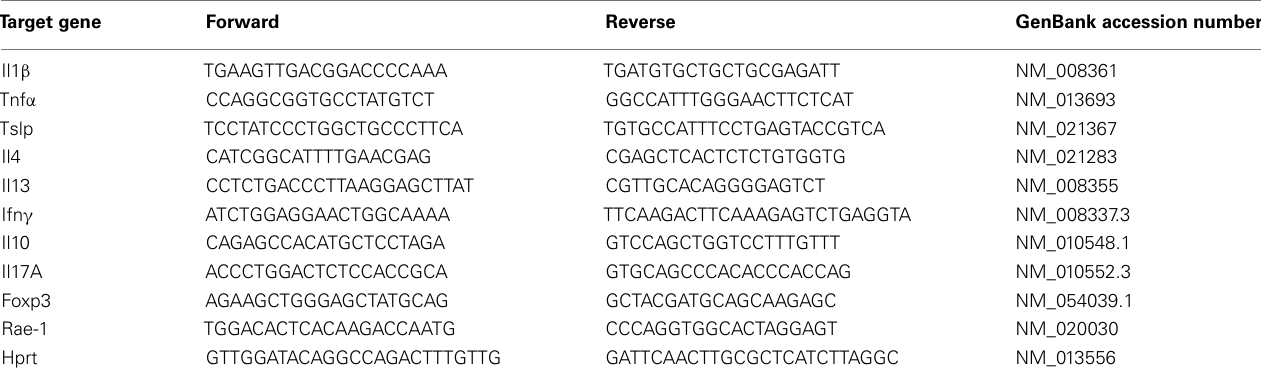
Table 1 | Real-time PCR primers used in this